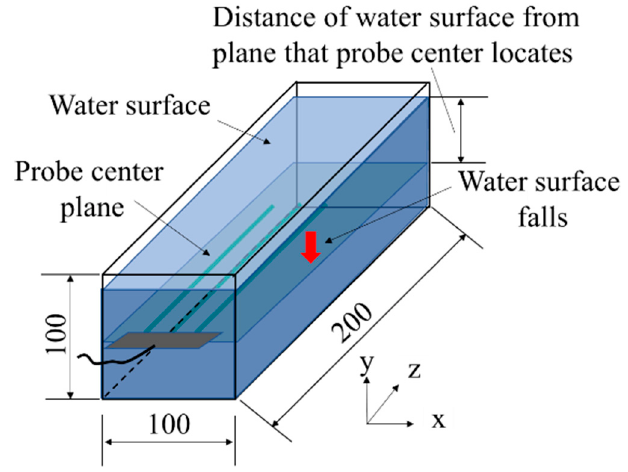
Figure 4. Schematic graph of setup used for calibration of the horizontal probe.